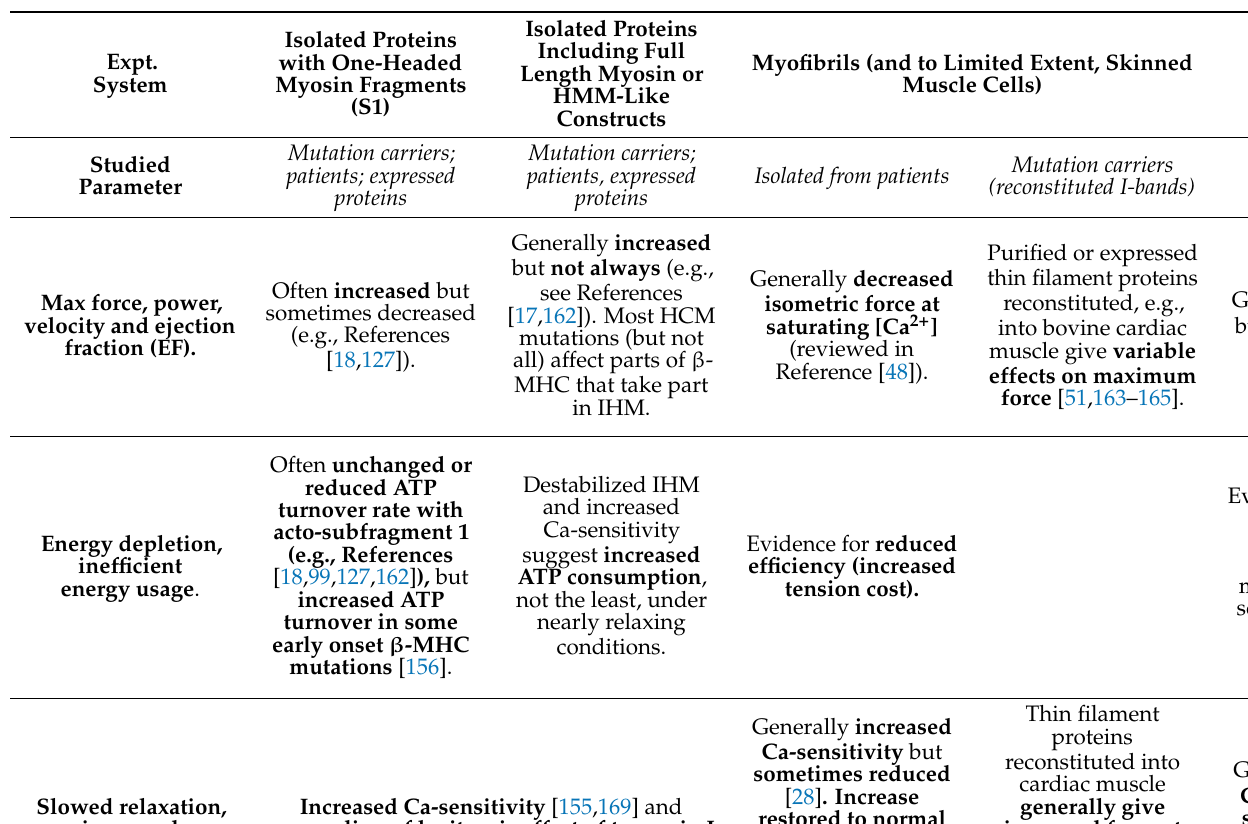
Table 2. Hypercontractility vs. hypocontractility from experiments and analyses on different hierarchical levels (2011 and later) a